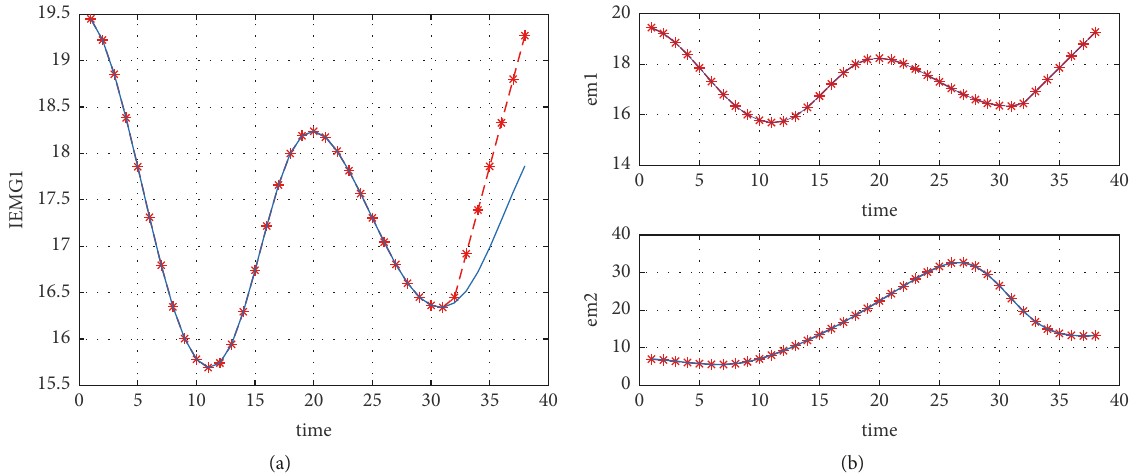
Figure 9: Ramp fault in IEMG signal. (a) Healthy and faulty IEMG signal. (b) Real and estimated faulty input.